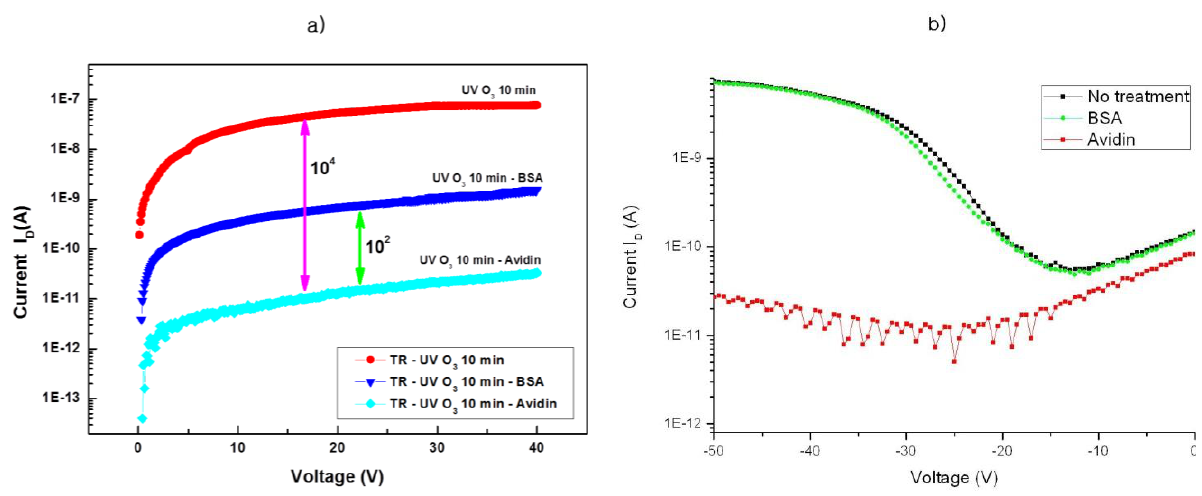
Figure 4. Changes of the characteristics of OTFT by detection of sensing materials. ( a ) Typical plot of drain current I versus gate voltage V between 0 and 40 V for D G biotinylated F8T2 TFTs. ( b ) On/Off-curve of the organic semiconductor field effect transistor (organic FET) before and after treatment with BSA or